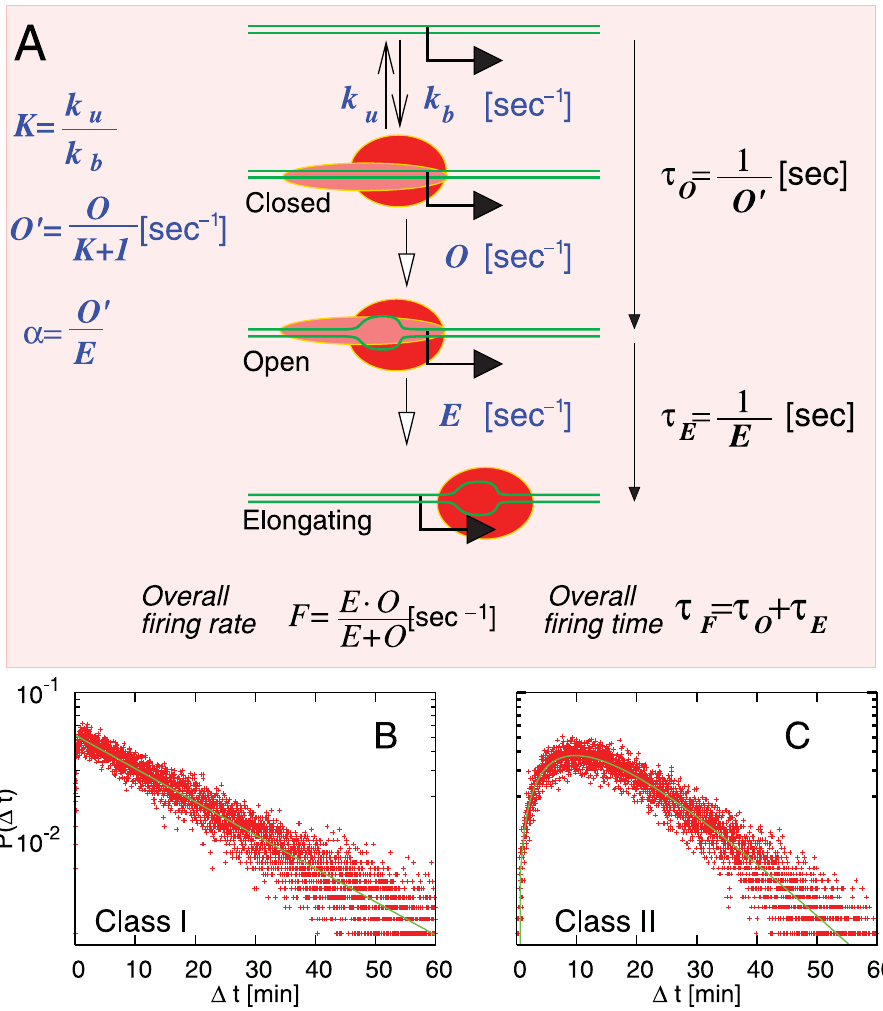
Figure 1. The Hawley-McClure 3-step model of transcription initiation. (A) First an RNAP forms a closed complex at the promoter with some on ( k b ) and off rates ( k u ), and subsequently forms an open complex with rate O . This process is a directed non-equilibrium transition. Finally, the open complex escapes the promoter into productive transcription with the one way rate E . (B–C) The distribution of intervals between transcription events for the standard 3-step model. For binding and unbinding rates of the closed complex we use k b = k u =60 [1/min]. The average total strength is F =1/ (20 [min]), whereas l =35 [bp] and v =25 [bp/sec]. (B) Class I: Probability distribution for time between transcripts D t for a promoter with a single rate limiting step. Here, it is isomerisation with O =1/(9.7 [min]). The escape rate from the open complex is E =1/(0.19[min]). Red dots: stochastic simulation results. Solid line: predicted distribution, (1/ t )exp[ 2 D t / t ] with t =19.4 [min]. (C) Class II; D t probability distribution for a promoter with two rate limiting steps because the isomerisation and escape rates are similar ( O =1/(4.9[min]), E =1/(9.7 [min])). Solid line shows the predicted distribution, (1/ t ) 2 D t exp[ 2 D t / t ] with t =9.7 [min].